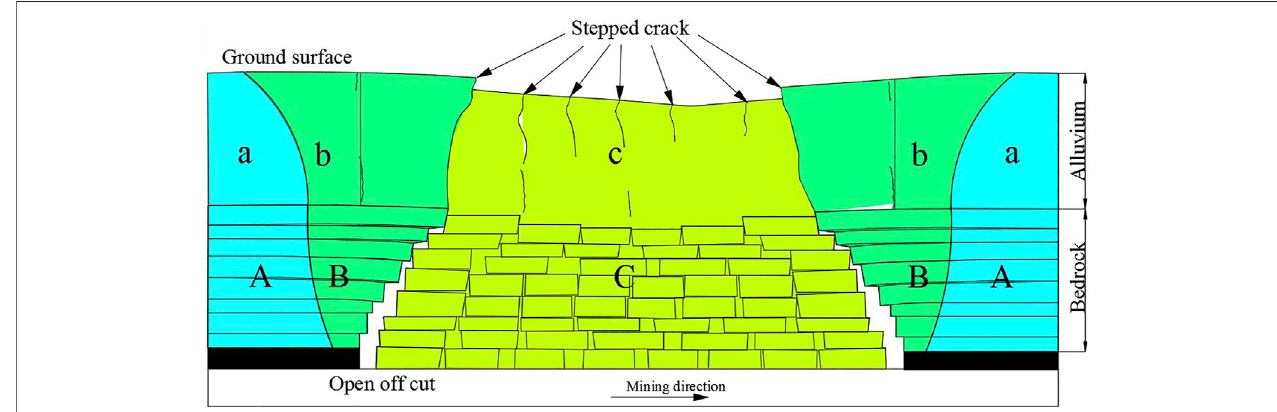
FIGURE 10 | Diagram of overburden failure under "two zones" mode